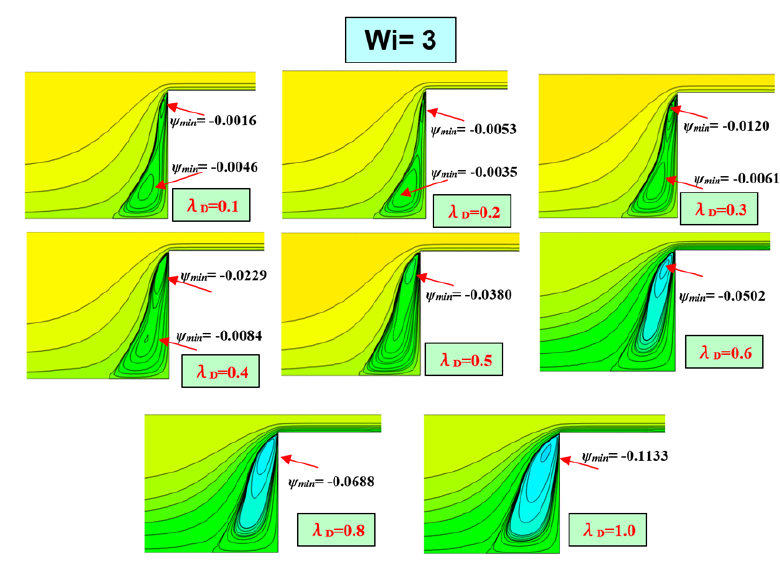
α = 8; Wi = 3; swIM [ L = 5, β ≤ 0.9]; λ aspect